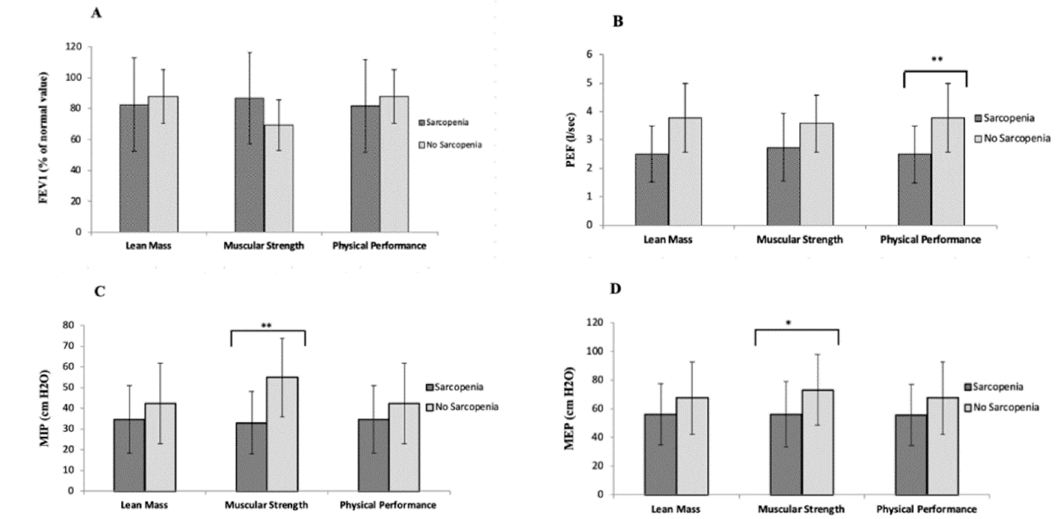
Figure 2. Mean difference of respiratory parameters (( A ): FEV1; ( B ): PEF; ( C ): MIP; ( D ): MEP) according to the presence or not of the three cut-off values for sarcopenia parameters * p < 0.05; ** p < 0.001.